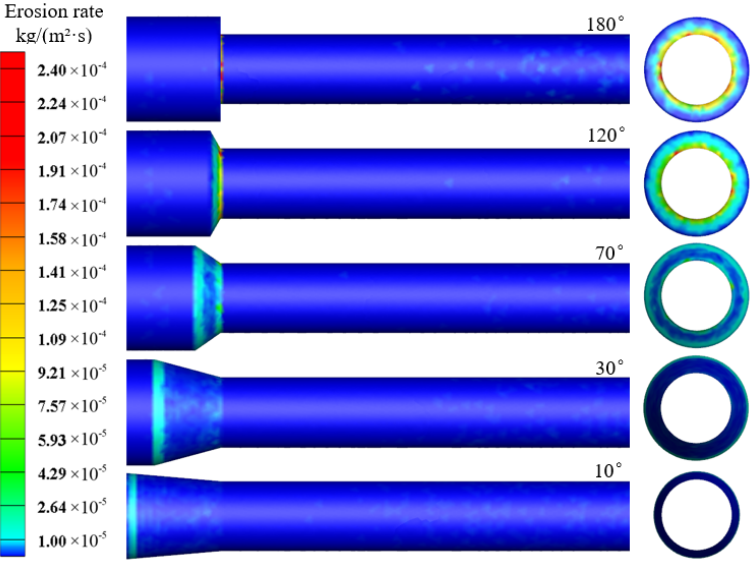
Figure 12. Erosion area changes with θ